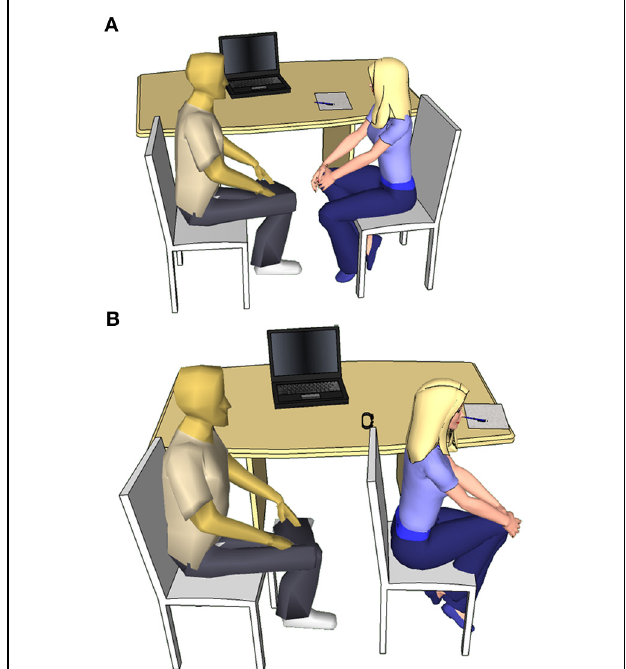
FIGURE 1 | Social interaction (A) and No social interaction (B) pretreatment